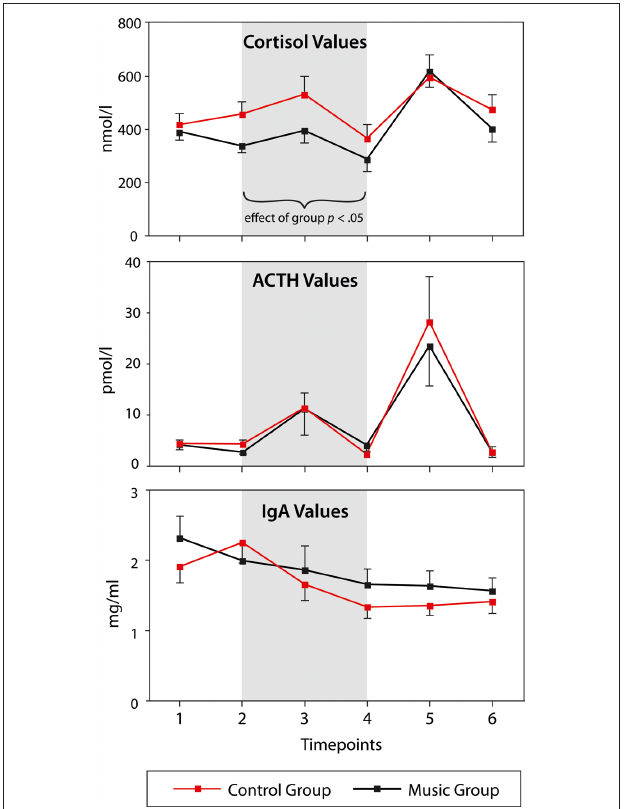
FIgure 3 | Cortisol, ACTH, and IgA values, separately for both groups (music group, control group) and the six different time points. Gray- shaded are indicate the intra-operative period. None of the parameters differed between groups at time point 1. During the intra-operative period, cortisol levels were lower in the music than in the control group. ACTH and IgA levels differed between time points, but not between groups. Error